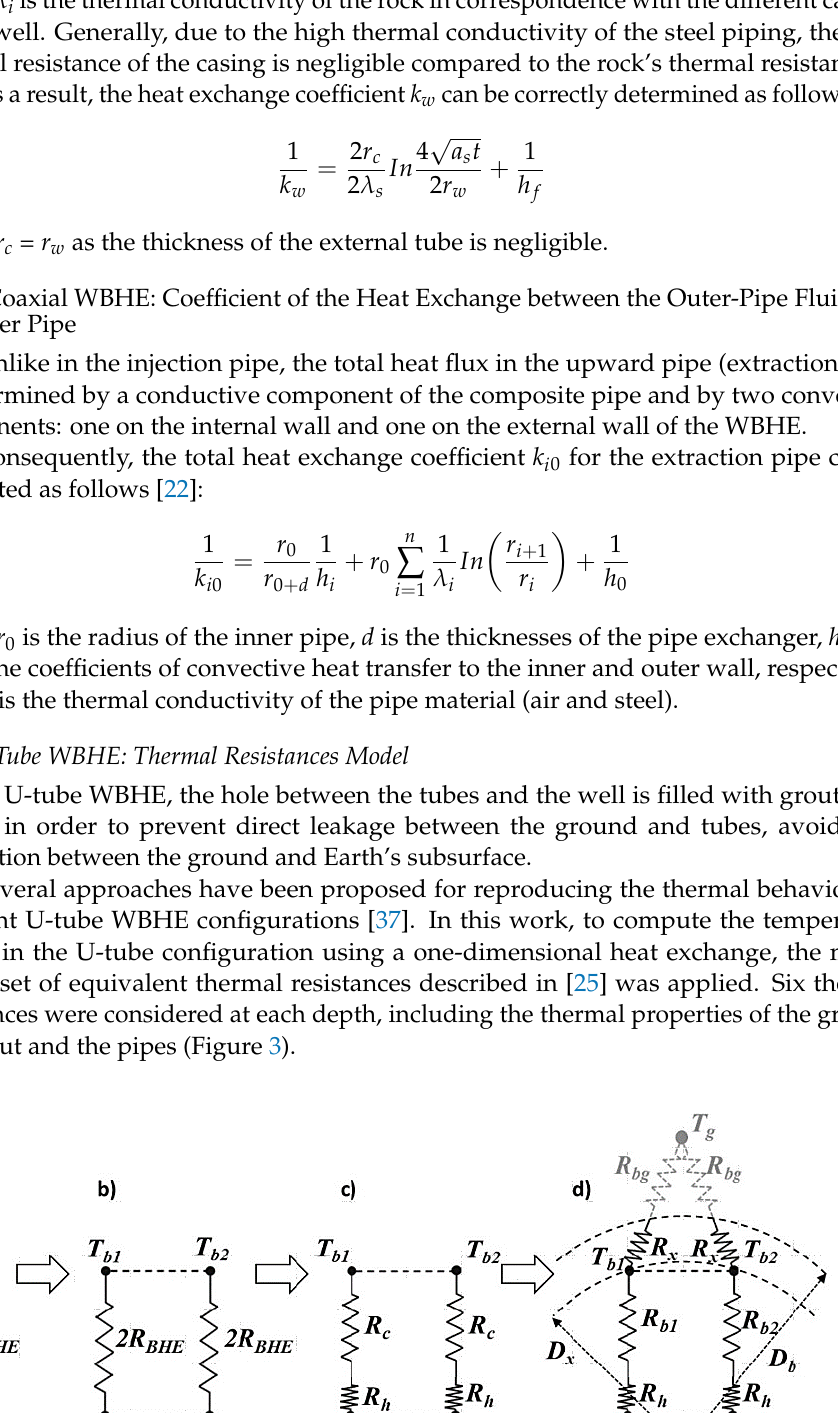
Figure 4. Geometrical model characteristics for calculating the equivalent diameter (modified from [22]. Copyright Elsevier, 2014). 2.5. WBHE Model Assumptions Python is a high-level programming language with an object-oriented approach de- scribed in [39]. As the Python software allows algorithms to be solved easily, it was used to perform the analysis of the WBHEs by implementing the described models (coaxial and U-tube-WBHE models) in different codes that have the structure illustrated in Figure 5. According to both selected models, the propagation of heat in the reservoir occurs through conduction; the propagation of heat inside the wellbore tubes takes place through conduction and convection phenomena. The reservoir model was built by assuming a sin- gle well located at the center of a circular reservoir. The temperature profile in the radial direction was assumed to be constant. There- fore, there was no temperature gradient in the annulus or the inner tube. Due to the tur- bulent flow, enhanced mixing phenomena occurred, which decreased the radial gradient. The temperature changed only in the annulus and in the vertical direction of the inner tube. Consequently, the temperature profile was unidirectional (vertical temperature pro- file). The properties of the heat carrier fluid were assumed to be constant. As the fluid used in this study was water (100 °C, 2 bar), no variations occurred due to pressure or/and temperature gradients. The analytical models were built under steady-state conditions; there were no tem- perature variations over time, with each point in the tubes (annulus and inner tube) main- taining the same temperature for the lifecycle of the system. In addition, the models con- sidered the resistance associated with tube thickness to be negligible. The tube material had very high conductivity (15 W/mK), so its resistance could be considered small com- pared to the other resistances in the system. For the estimation of resistance associated with the rock (see Equation (6)), the time value used was 3 years. The analysed system, in the period preceding the three years (1 – 3 years), turns out to ensure larger heat exchange phenomena with the possibility of causing overestimation in energy performances.